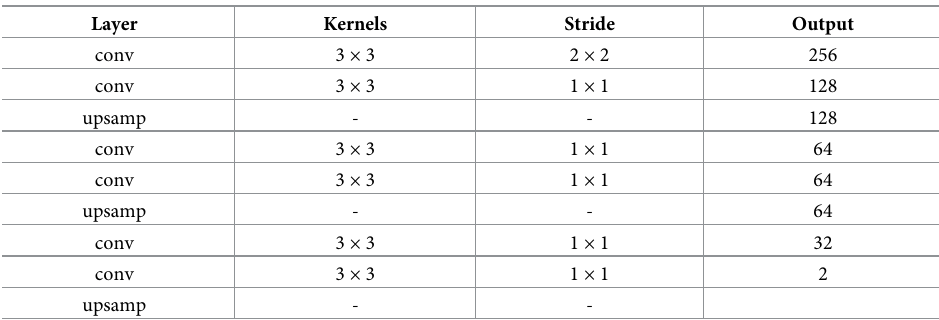
Table 2. Parameter settings of color prediction